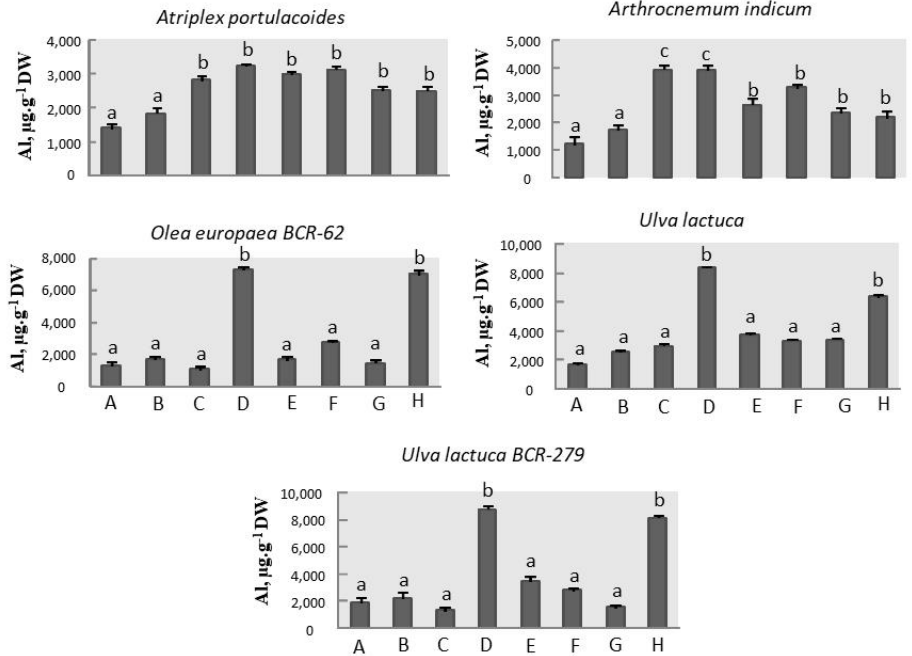
Figure 4. Contents of Al ( µ g · g − 1 DW) in atriplex portulacoides, arthrocnemum indicum, olea europea BCR-62, ulva lactuca and ulva lactuca BCR-279 using methods A, B, C, D, E, F, G and H. Values were presented as mean ± standard deviation, n = 10. Letters (a, b, c) show a significant difference ( p < 0.05) between the concentrations attained by different extraction procedures.